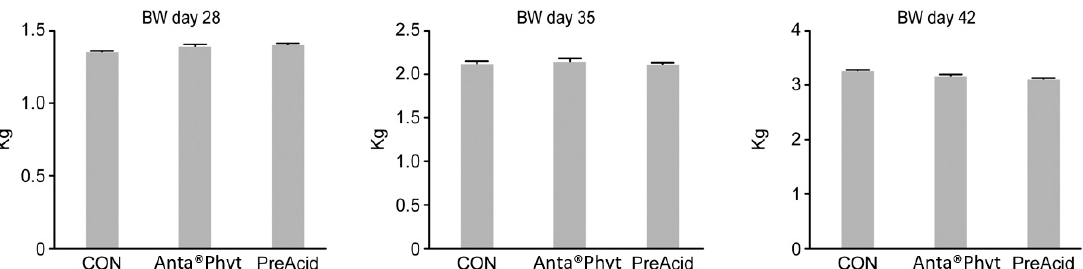
Figure 1. The effect of the dietary treatments on the body weight (BW) of chickens at days 28, 35 and 42 of age. Birds were fed a control diet (CON); the control diet supplemented (on top) with phytogenic ingredients from hops, licorice and arabic gum (Anta ® Phyt); or a diet supplemented with a mixture of a free butyrate acidifier and prebiotic gluconic acid (PreAcid). Data are the means ± SEMs of 12 replicates per treatment. Differences between groups were considered significant when p < 0.05.